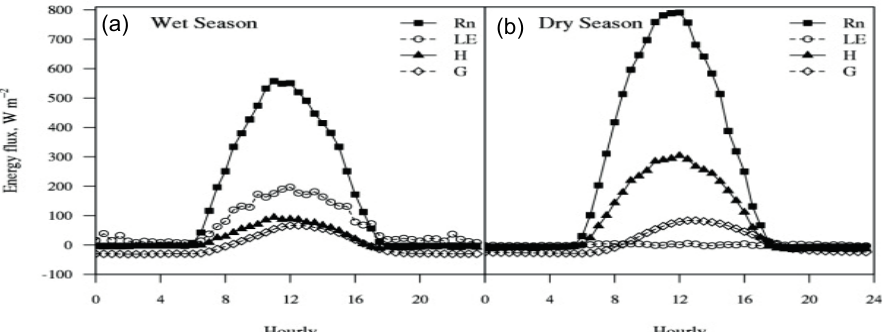
Fig. 6 Energy balance components: (a) wet season, (b) dry season.